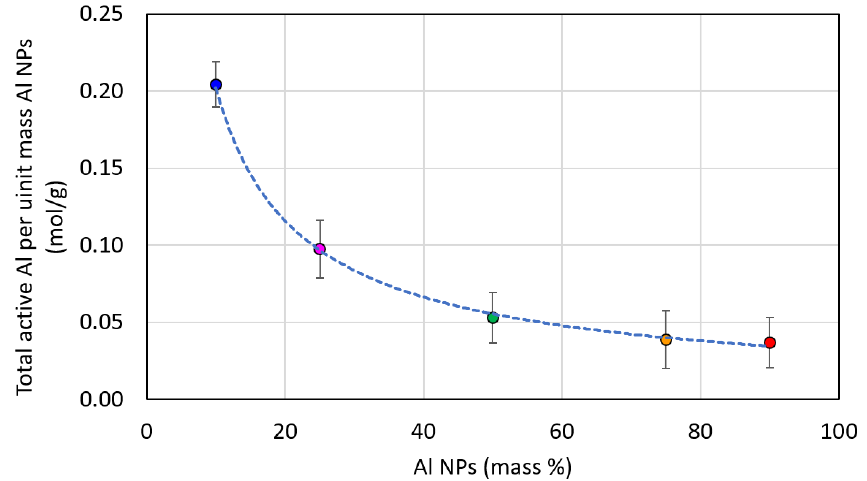
Figure 3. Total amount of active Al 0 per unit mass of Al NPs as a function of mass % of Al NPs in the sample.